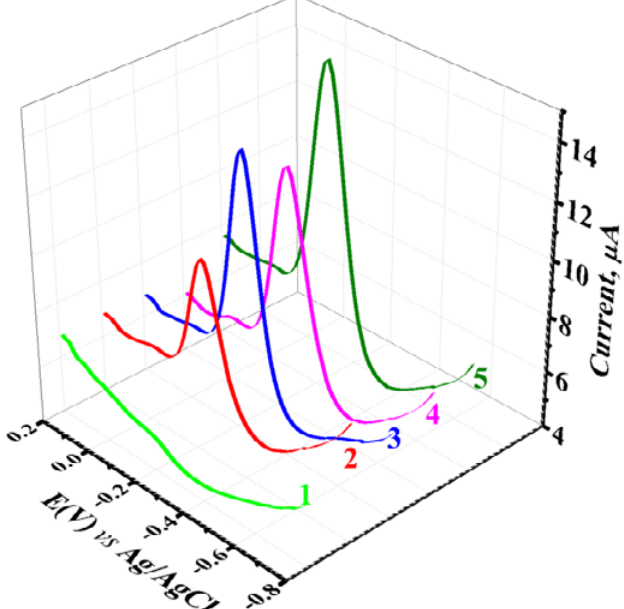
Figure 6. DPV curves obtained in 0.1 M PBS (pH 8) containing 1 µM of TB on (2) bare GCE, (3) GCE/HA, (4) GCE/Lys and (5) GCE/Lys/HA. (1) represents the curve recorded in blank electrolyte using GCE/Lys/HA.